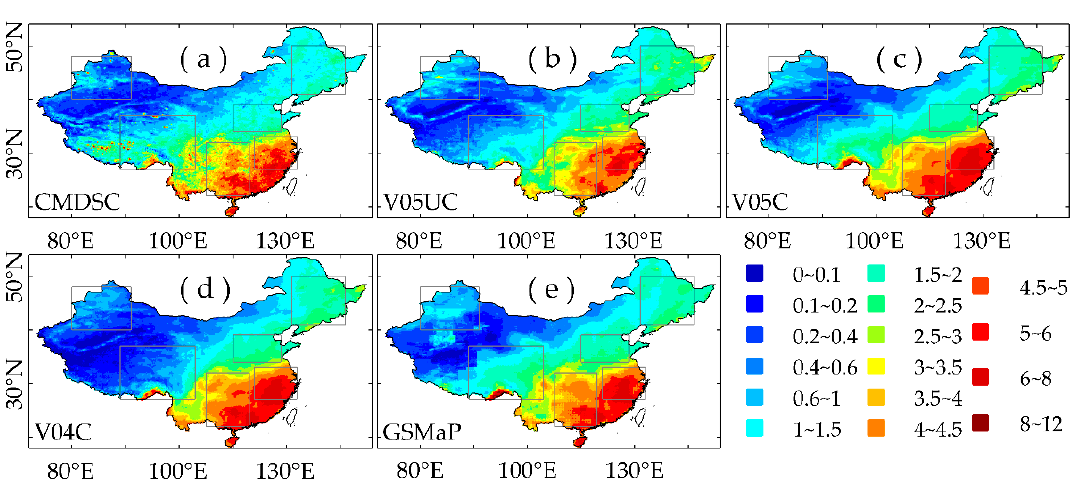
Figure 2. Spatial distribution of daily average precipitation (mm/day) during April 2014 and December 2016 at 0.1° × 0.1° resolution derived over mainland China: ( a ) China Meteorological Date Service Center (CMDSC), ( b ) V05UC, ( c ) V05C, ( d ) V04C and ( e ) GSMaP.